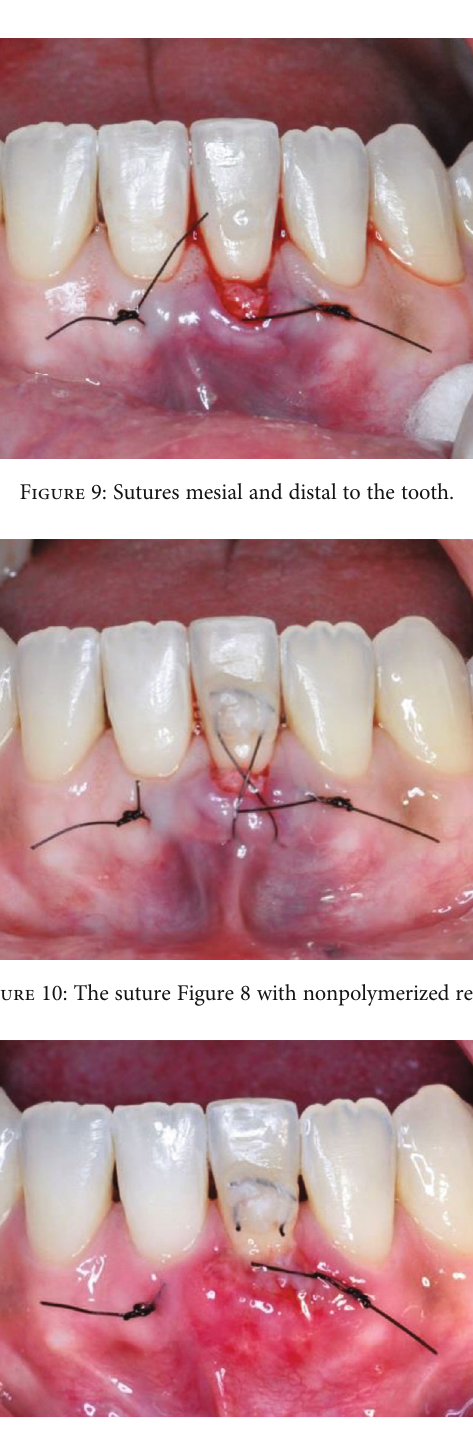
Figure 8: Two horizontal mattress sutures.